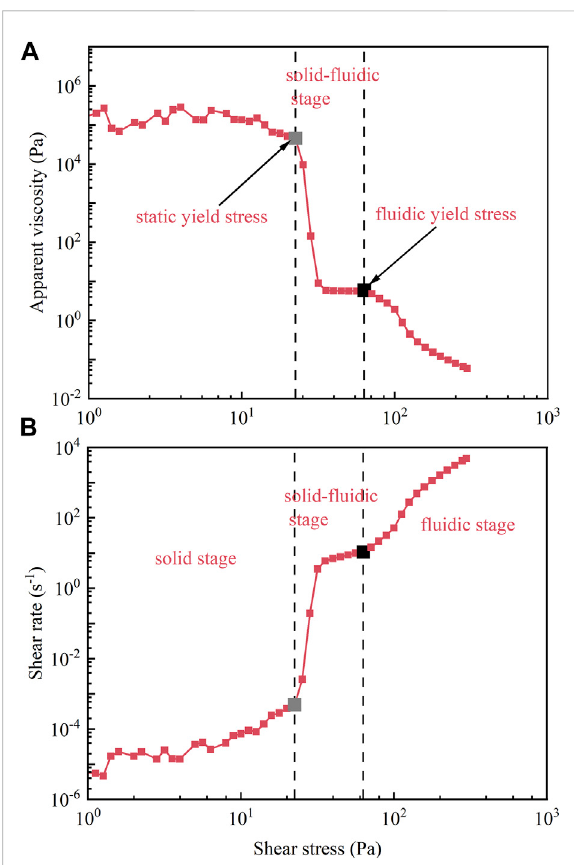
FIGURE 4 The apparent viscosity (A) and shear rate (B) evolution with increasing shear stress of the Wenzhou#1 mud sample. In the fi gure,thegreypointandtheblackpointrepresentthe fi rstyielding point and second yielding point of the Wenzhou#1 natural mud sample,